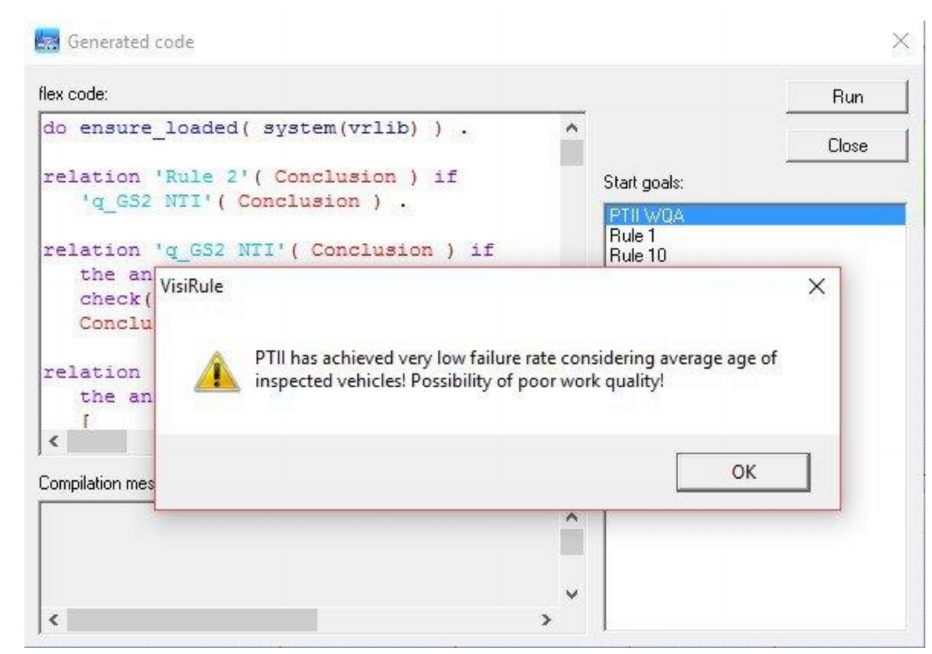
Figure 3. Display of the message indicating a successful validation of the ES. 4.7. The Analysis of the Impact of the PTII WQA Systems Application on the Quality of PTI